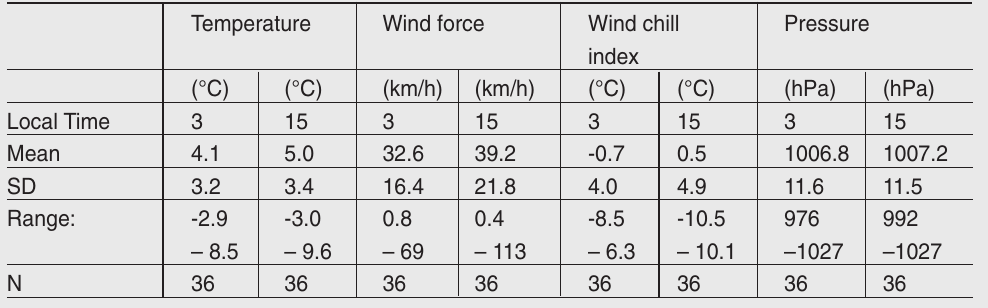
Table 1 : General weather conditions at the Faroe Islands recorded at Klaksvík during 22 February–29 March 2010 when an adult male walrus visited the